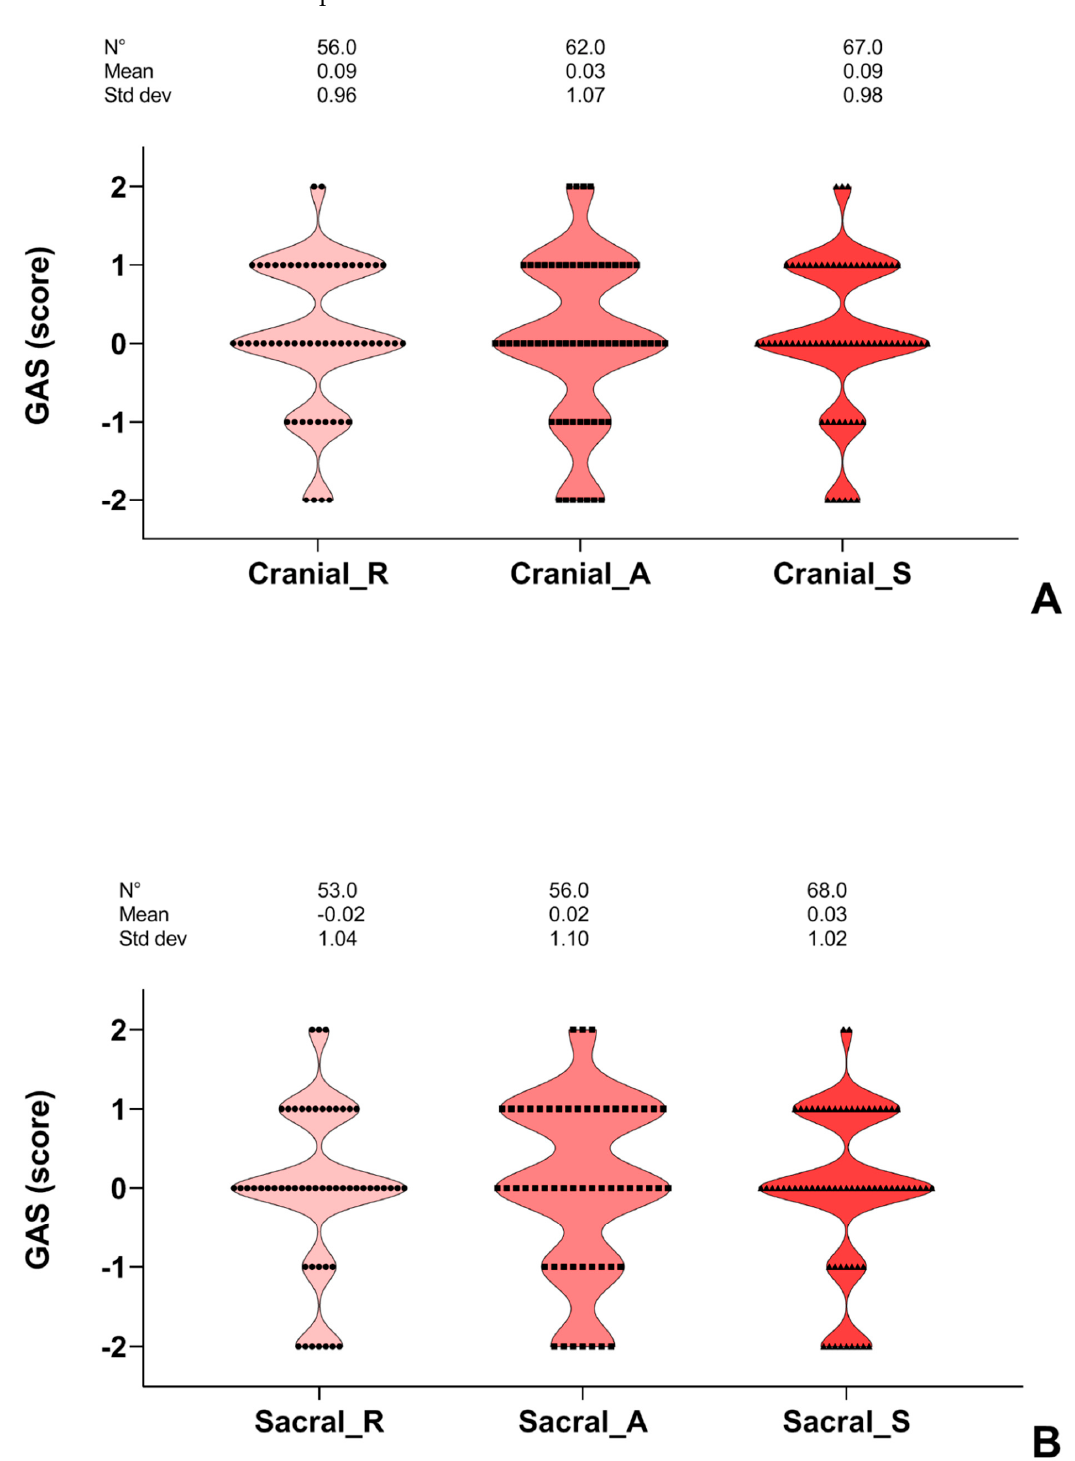
Figure 3. ( A , B ) The violin plot graph shows the goal attainment scaling (GAS) scores of the cranial and sacral impulse (CRI) districts. Only children, adolescents, and young adults with medium or high adherence to the training sessions and osteopathic treatments were considered (see the method section for further details). R, rhythm; A, amplitude; S, strength. In Figure 3B, the GAS scores of the CRI cranial functions are shown. In 42% of cases, a GAS score of “0” was obtained for all of the parameters. Better outcomes than